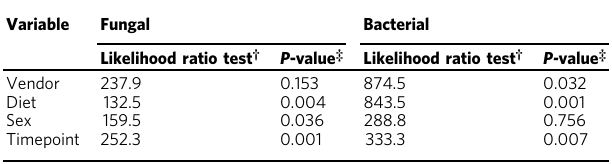
Table 1 Determinants of microbial community composition in healthy